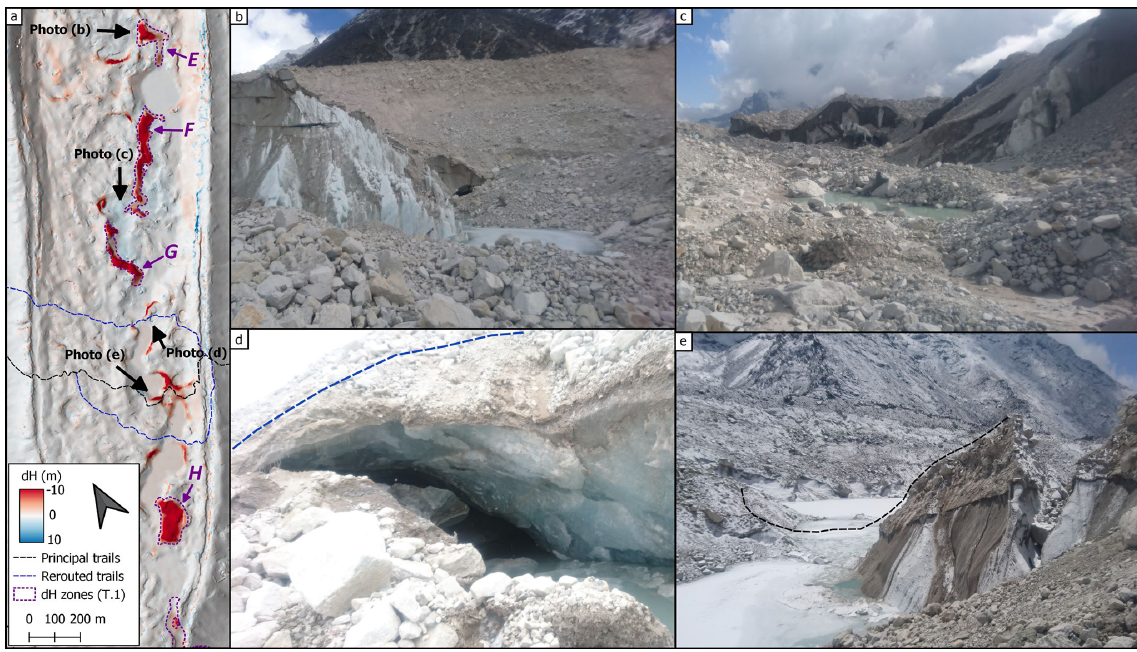
Figure 5. Flood-related geomorphic evidence on Khumbu Glacier. Surface lowering, rerouting of the Kongma La trail, zones of analysis (Table 1), and positions of selected photos of enhanced change over the lowermost 3km of Khumbu Glacier, with hillshade of March Pléiades DEM as background (a) . The area of a conduit collapse (Zone E), with visible water flowing towards the exposed conduit entrance (b) . A zone of fluvially reworked debris directly located down-glacier from the conduit collapse in Zone F, leading to exposed shallow conduits in the background (c) . A cavernous englacial conduit exposure directly beneath the rerouted Kongma La trail (d) . The route of the pre-event Kongma La trail, now cut off by a fresh conduit collapse ( e , at right) and coalescing ponds. All photographs taken by the authors in May 2018.